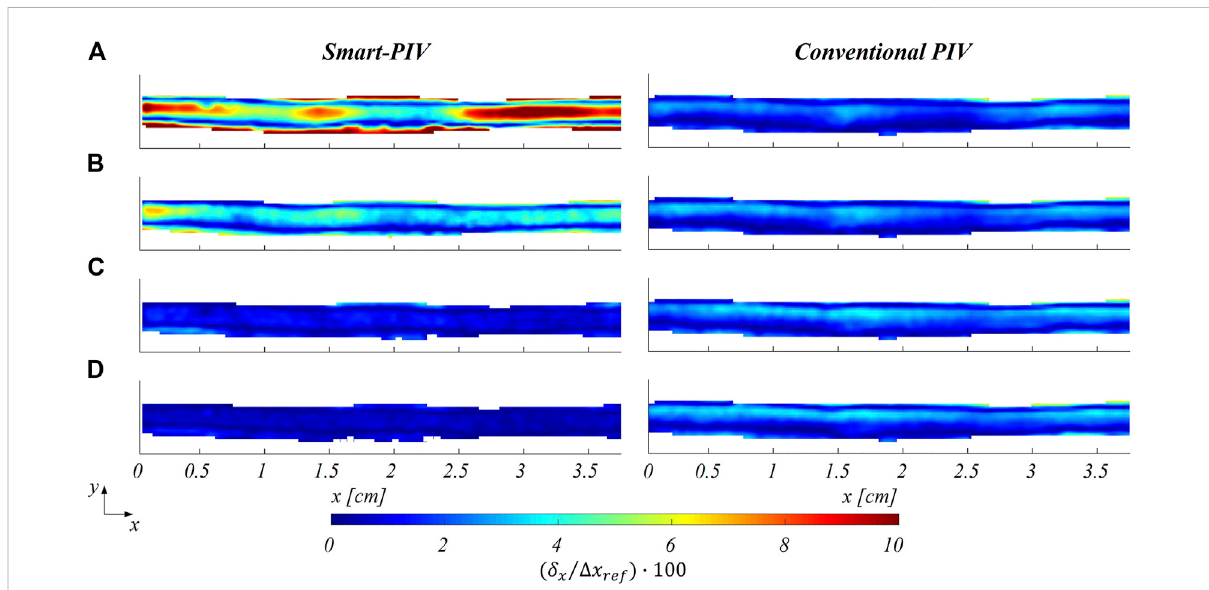
FIGURE 9 Color maps of smart (left panel) and conventional (right panel) PIV displacement errors along the streamwise fl ow direction δ x , normalized to themaximumstreamwiseparticledisplacement( Δ x